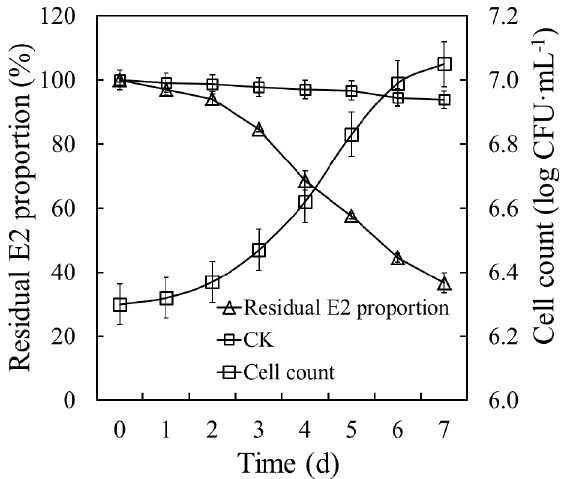
Figure 3. E2 degradation dynamics and growth curve of strain E2S in estrogen mineral salt medium (EMM). CK represents the non-inoculation treatment; CFU means colony forming unit.